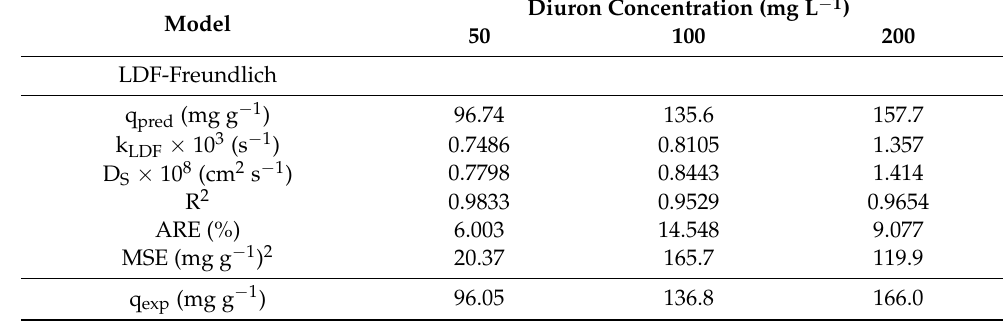
Table 4. The kinetic parameters were estimated for the adsorption of Diuron in the CPAC. Model